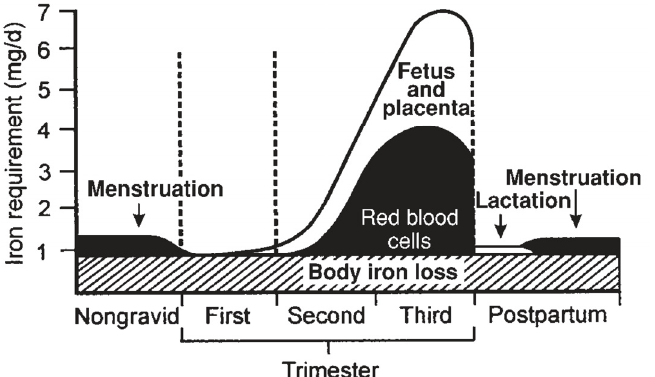
Figure 1. Estimated daily iron requirements during pregnancy in a 55-kg woman [5]. (with permission to publish photo from The American Journal of Clinical